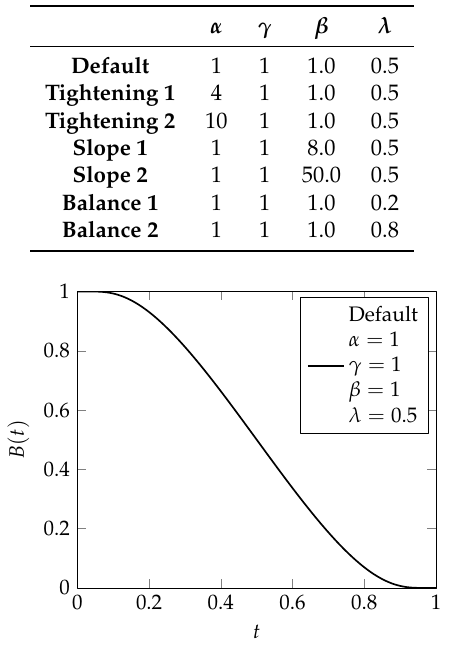
Figure 7. Plot of the default ERB-function. Figure 8. Plots of ERB-functions with